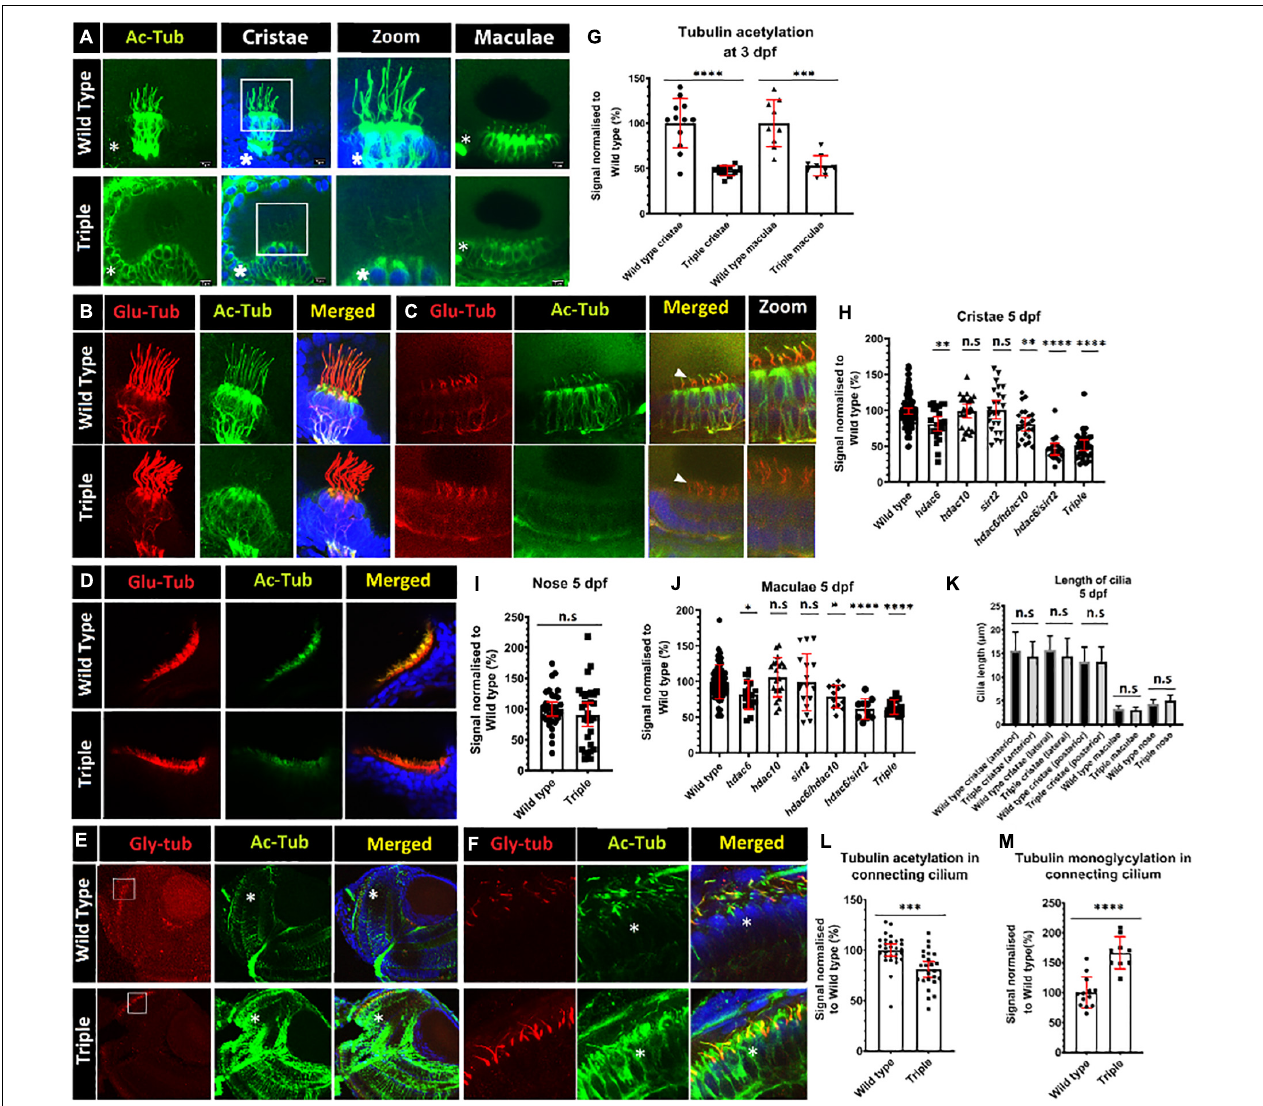
FIGURE 3 | Decrease of acetylation in cilia in hdac mutants. (A) Comparison of levels of tubulin acetylation (green) between 3 dpf wild-type embryos and triple mutant embryos in cristae and macule. Squares shows zoomed in areas. (B–D) Double staining for acetylated (green) and glutamylated (red) tubulin, 5 dpf of wild type and triple mutants. (B) cristae (C) macule, and (D) nose. (E) Increased tubulin acetylation (green) of cell bodies in the retina of 5 dpf embryos, and increased levels of mono-glycylation in a subset of cilia (red). (F) Zoom of connecting cilia increased mono-glycylation as well as a lower level of acetylation in the triple mutants. (G) Level of tubulin acetylation in cilia in wild type and triple mutants, normalized to wild type, for cristae and macule of 3 dpf embryos. (I) Unaffected level of acetylation in nose cilia. Change of cristae (H) macule (J) and cilia tubulin acetylation in hdac6, hdac10, sirt2, hdac6/hdac10, hdac6/sirt2, and triple mutants. (K) Comparison of cilia length between wild type and triple mutants in cristae (anterior and lateral posterior) macule and nose. (L) Decrease in connecting cilium axoneme acetylation in photoreceptors in triple mutants and M) increase in tubulin mono-glycylation in triple mutant cilia. Asterisks show increased level of tubulin acetylation in cell bodies. [Mean with 95% CI. (G,I,L,M) t -test * p < 0.05, ** p < 0.01, *** p < 0.005, **** p < 0.0001]. ns, no significant. [ (H,J,K) one-way ANOVA * p < 0.05, ** p < 0.01, *** p < 0.005, **** p < 0.0001]. ns, no